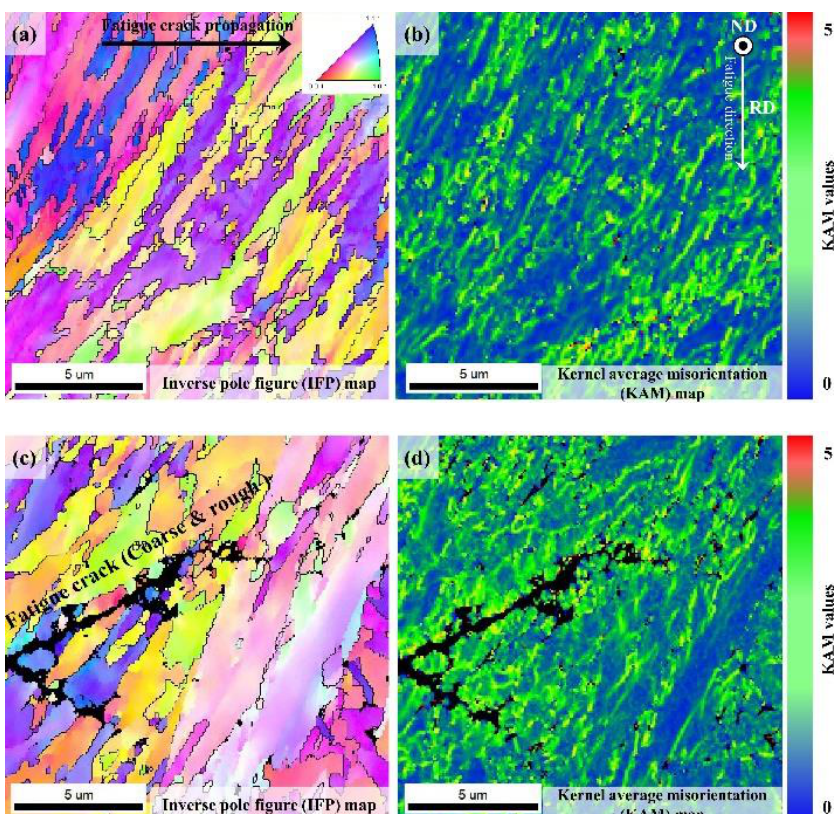
Figure 15. ( a ) IQ map observed after high-cycle fatigue; ( b ) KAM map of alloy A; ( c ) IQ map and ( d ) KAM map of alloy B.